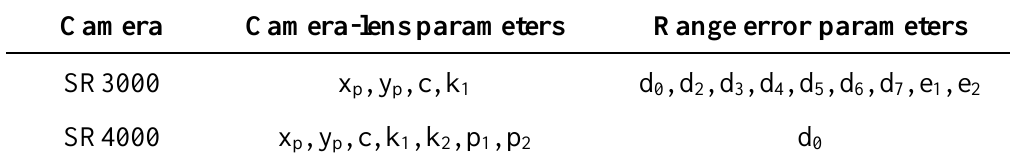
Table 1. Calibration parameters for the two cameras